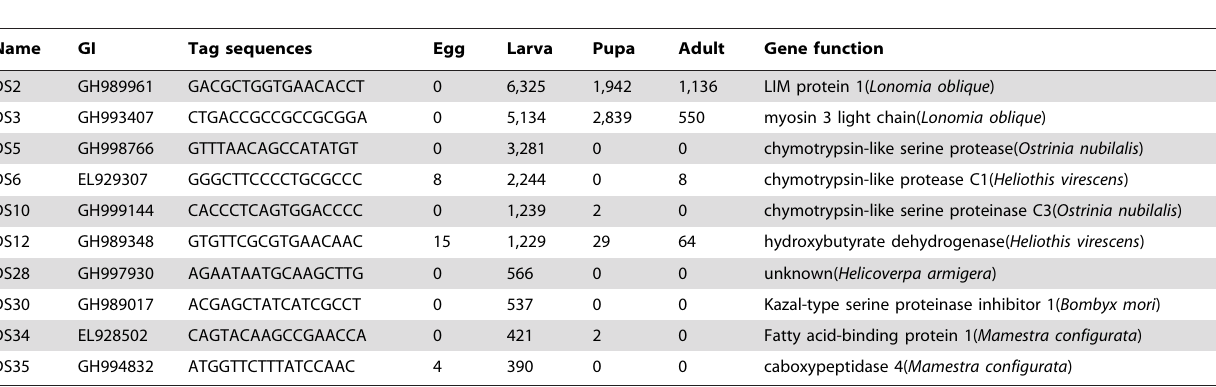
Table 5. Ten larval stage specific expression gene tag sequences, copy number in each stage and their function